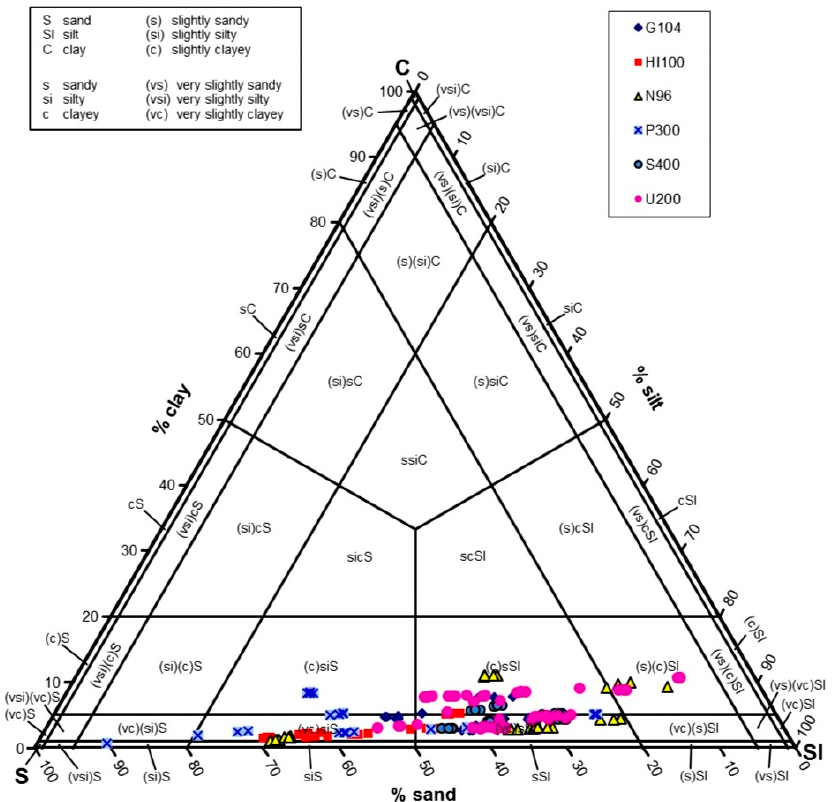
Figure 7. Particle size distribution diagram of the samples. Sediment samples can be clustered into four main groups according to the textural groups. Most of them have silty-sand and sandy-silt